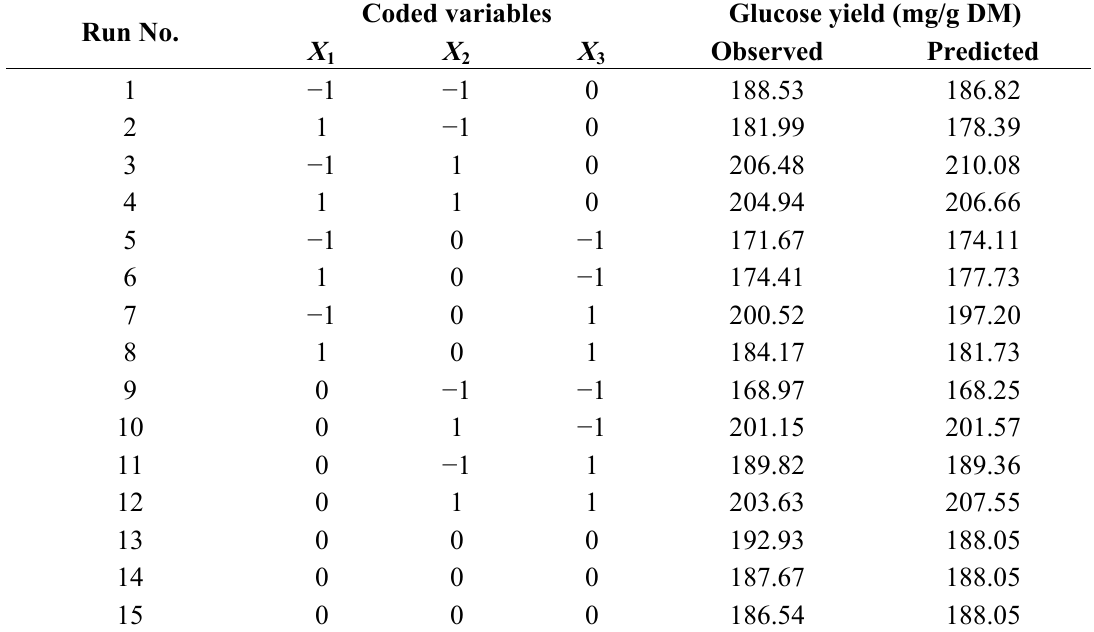
Table 3. Box-Behnken design for the three variables showing observed and predicted results for glucose yield of L. punctata under pectinase pretreatment. Run No.